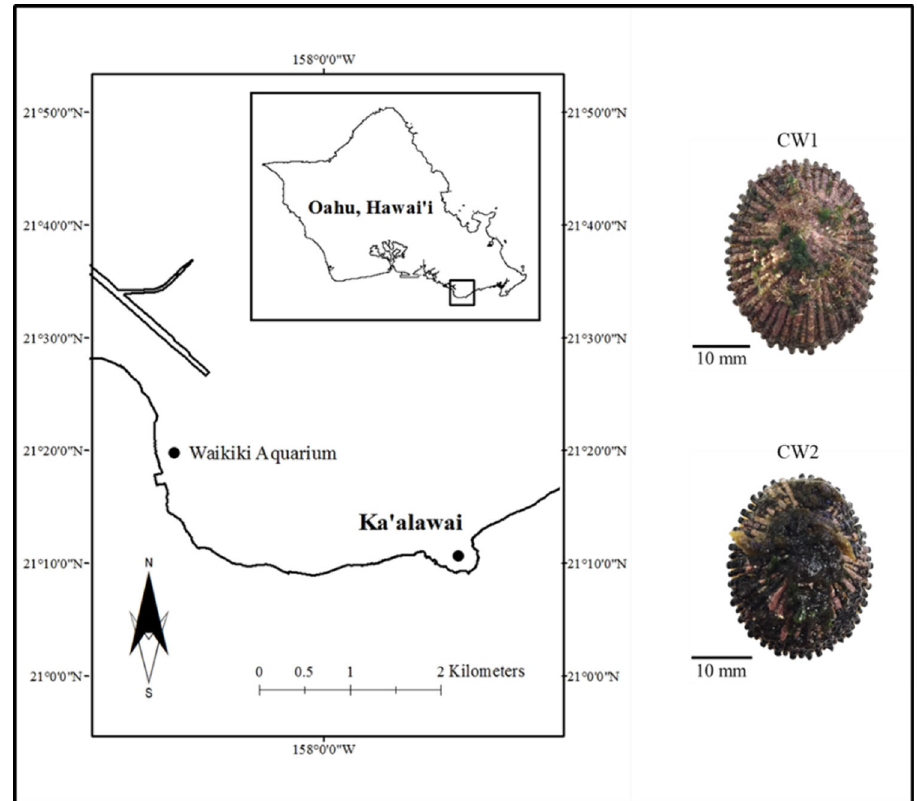
Fig. 7 Study site map. Hawaiian limpet specimens ( Cellana sandwicensis ) were collected along the rocky intertidal shoreline of Ka ’ alawai (Oahu, Hawaii). Instrumental sea-surface temperatures were measured in-situ by PacIOOS Nearshore Sensor 04 (NS04) at the Waikiki